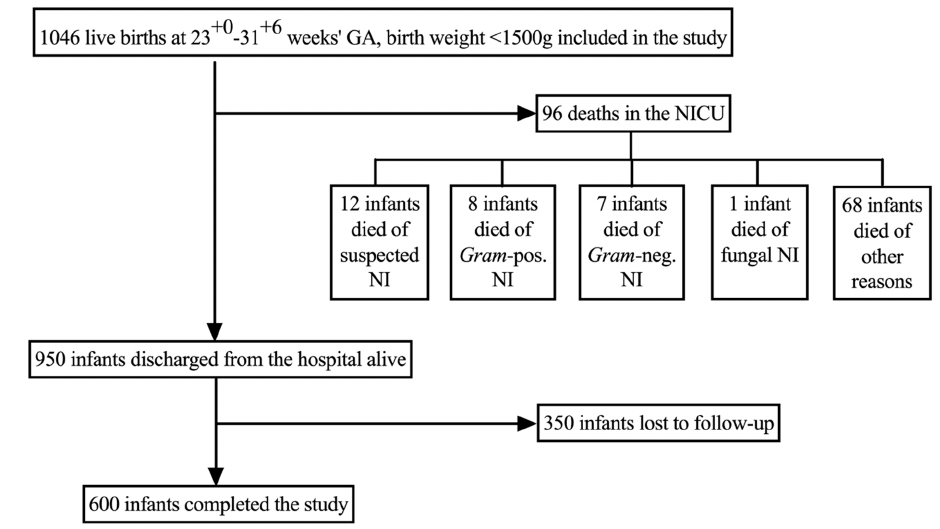
Figure 1. The study cohort.